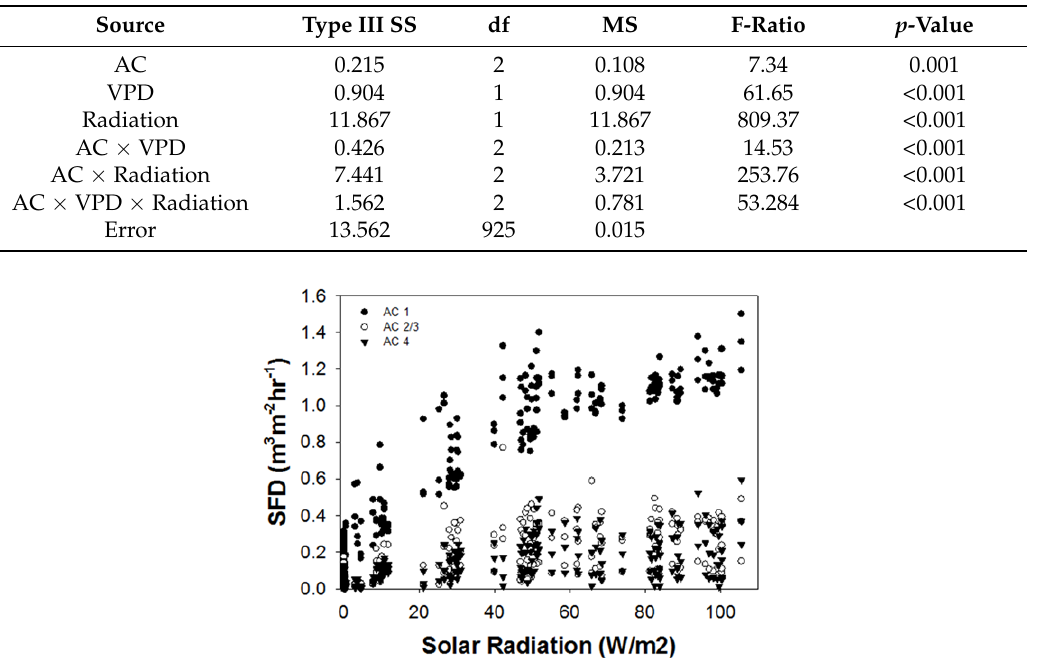
Figure 2. Half hourly sap flux density (SFD) of Fraxinus trees in relation to solar radiation (W/m 2 ) during 26–30 June 2010 (AC1 = low, AC2/3 = moderate, AC 4 = high infestation levels).